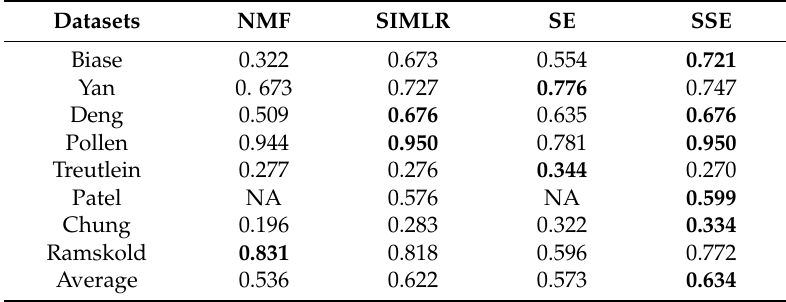
Table 2. Cluster performance comparison of NMF (nonnegative matrix factorization), SIMLR (single-cell interpretation via multikernel learning), SE (structural entropy minimization principle), and SSE (single-cell structural entropy minimization principle) in terms of NMI (Normalized mutual information).